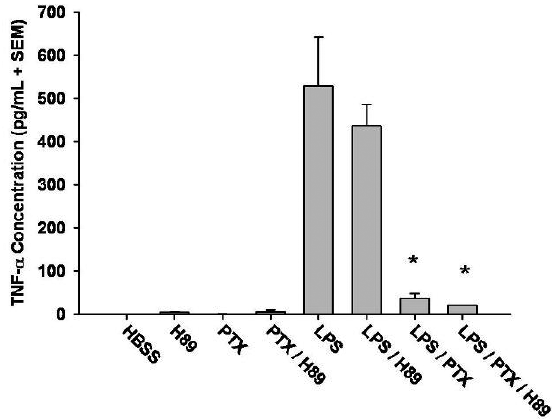
Figure 5 - Phosphodiesterase inhibition downregulates LPS-induced TNF- α production independent of Protein kinase A (PKA). Isolated mononuclear cells (5 x 10 6 ) were preincubated with the PKA inhibitor, H89 (10 µM), for one hour prior to stimulation with LPS (1 µg/mL) or LPS (1 µg/mL) and Pentoxifylline (PTX; 20 mM) for an additional 30 minutes. The concentra- tion of TNF- α present in the supernatant was measured by ELISA. PTX downregulated LPS-induced TNF- α expression (*, P < 0.01 vs. LPS). The addition of H89 did not significantly alter the effects of PTX on TNF- α production after LPS